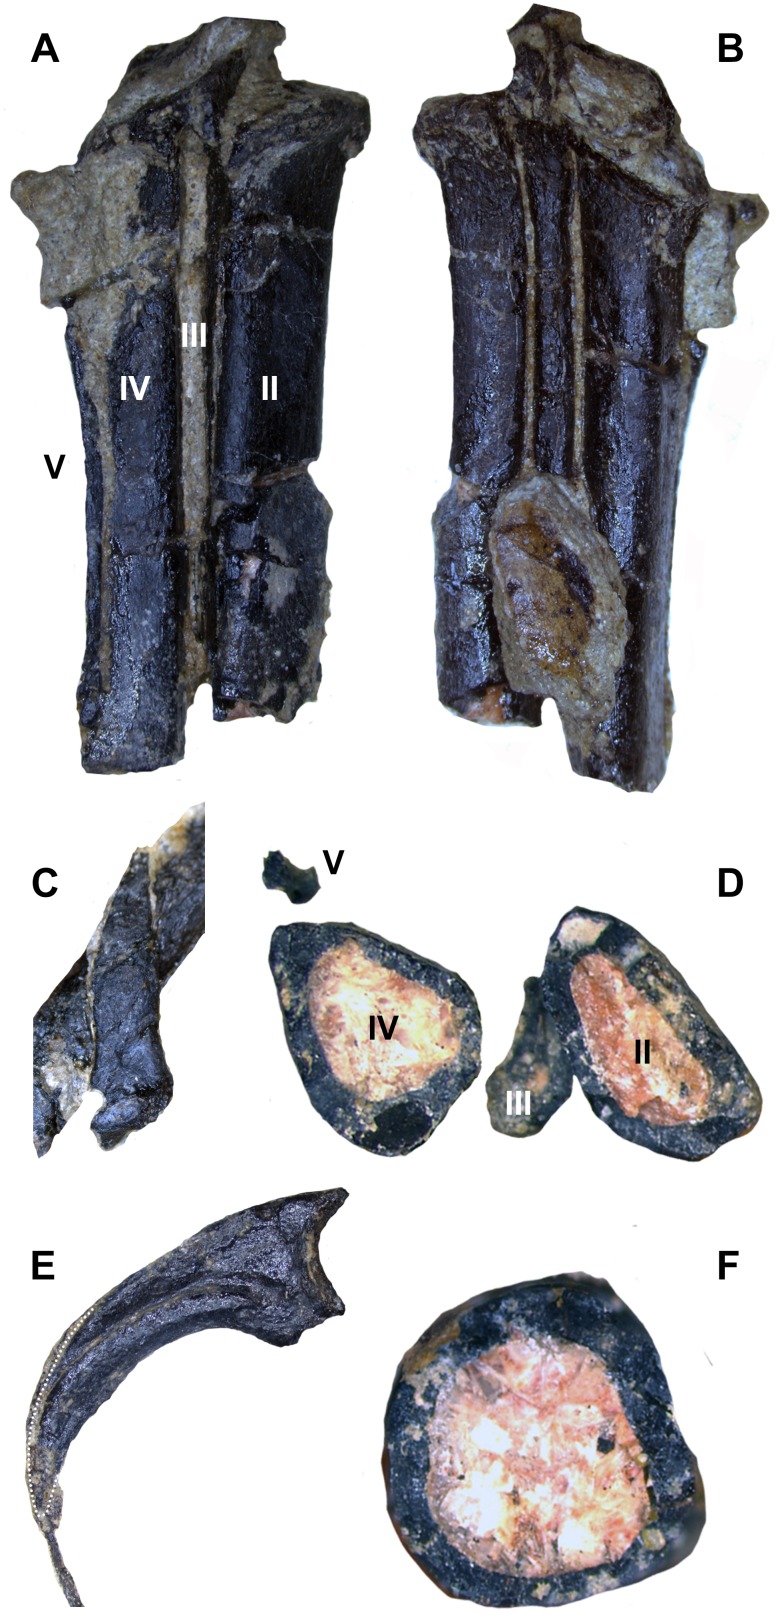
Select hindlimb elements of WYDICE-DML-001.Proximal end of left metatarsal packet in posterior (A) and anterior (B) views. (C) Right metatarsal I in medial view. (D) Cross-section through left metatarsals from distal perspective, anterior is to the bottom. (E) Enlarged pedal ungual II: material outside the dotted line is inferred to be preserved sheath material. (F) Cross-section through the left tibia at mid-shaft.